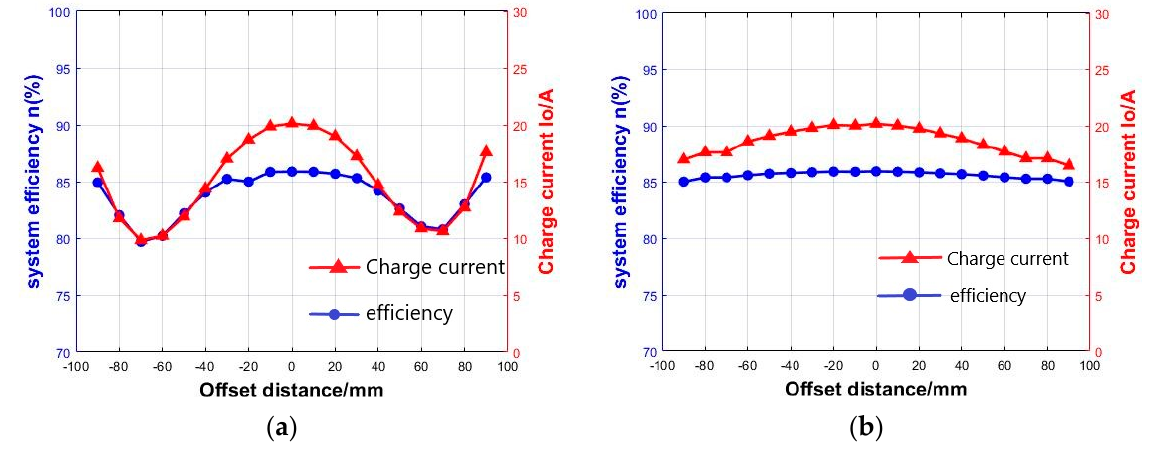
Figure 21. Charging power and system efficiency versus ( a ) lateral displacement and ( b ) longitudi- nal displacement.